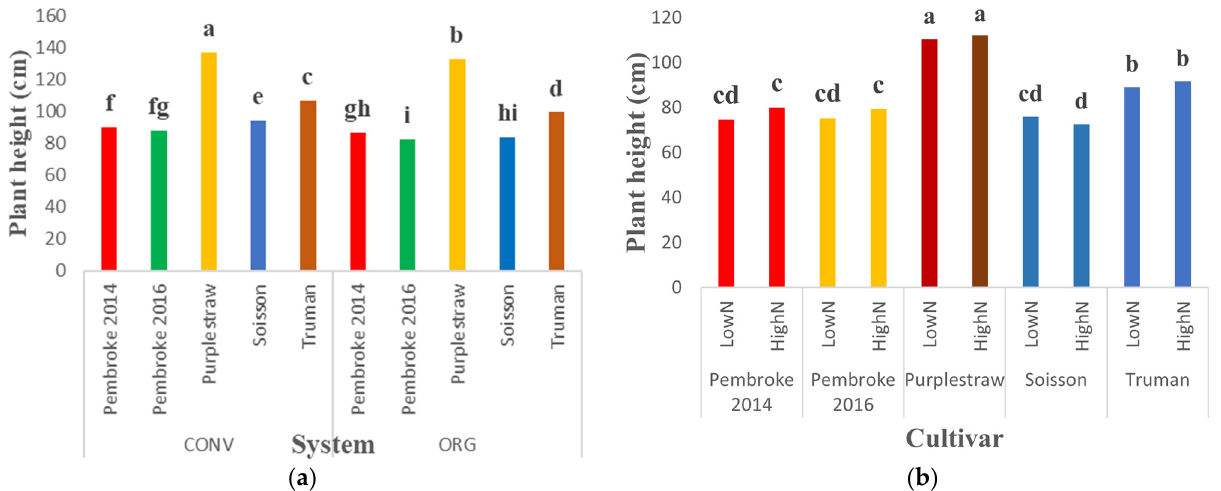
Figure 1. Plant height of soft red winter wheat cultivars as affected by production system in Y2 ( a ) ( p < 0.0001) and by fertilizer nitrogen rate in Y1 ( b ) ( p = 0.0327). Bars with the same letters within each figure are not significantly different based on Tukey’s honest significant difference (HSD) test performed at α = 0.05.